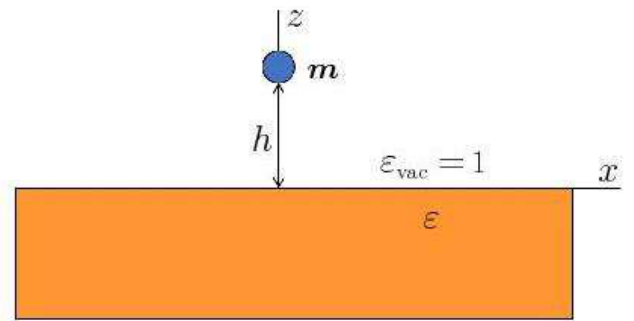
Figure 1. Magnetic dipole spaced in a vacuum above thick metallic plate described by the dielectric permittivity ε